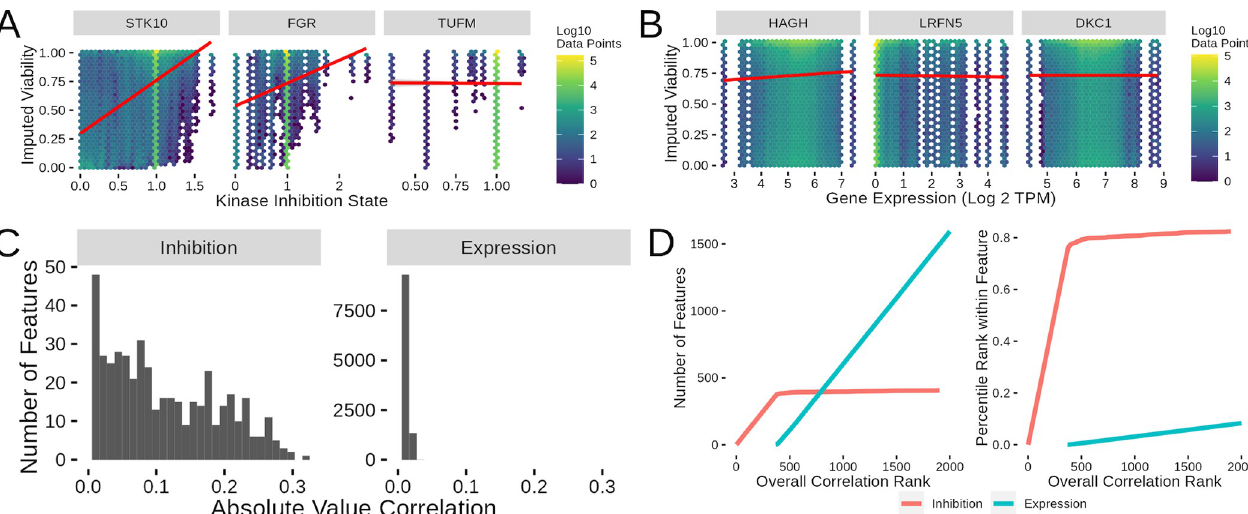
Fig 2. Single Feature Correlations Across Kinase inhibition and Gene Expression. (A) Sample kinase inhibition state versus imputed viability heatmap plots showing inhibition states with high (STK10), medium (FGR) and low (TUFM) correlation values. (B) Sample gene expression versus imputed viability heatmap plots showing genes with high (HAGH), medium (LRFN5) and low (DKC1) correlation values. (C) Overall distribution of correlations between kinase inhibition states and gene expression levels. (D) Plots showing what order classes of features are selected from the inhibition and expression correlations. The number of features from each class (left) selected at a given rank value and the percentage of the possible features (right) selected at a given feature selection rank cutoff.